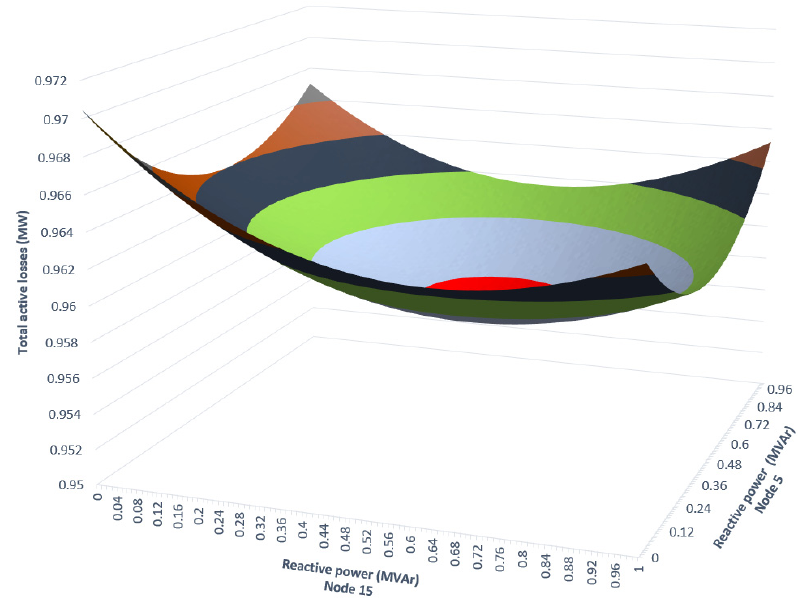
Figure 8. Dependence of the total active losses on the reactive